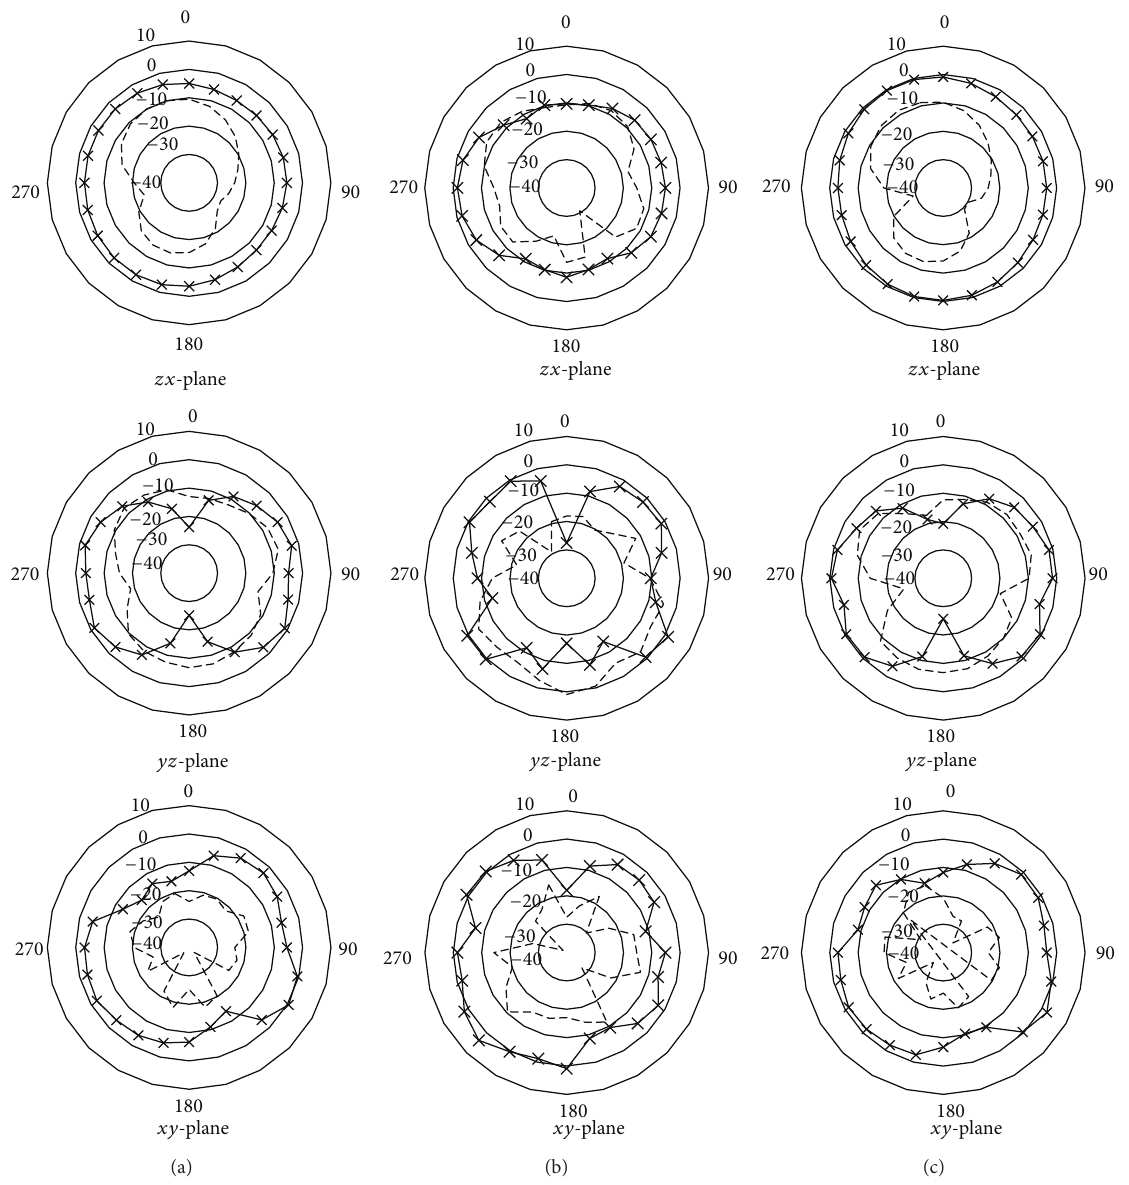
Figure 4: Measured radiation patterns for the proposed antenna (- × - copolar.—cross-polar.). (a) 660 MHz, (b) 2450 MHz, and (c) 5500 MHz. (23.63%) at 660 MHz, 2450 MHz, and 5500 MHz, which meet the required bandwidths of the DVB and WLAN